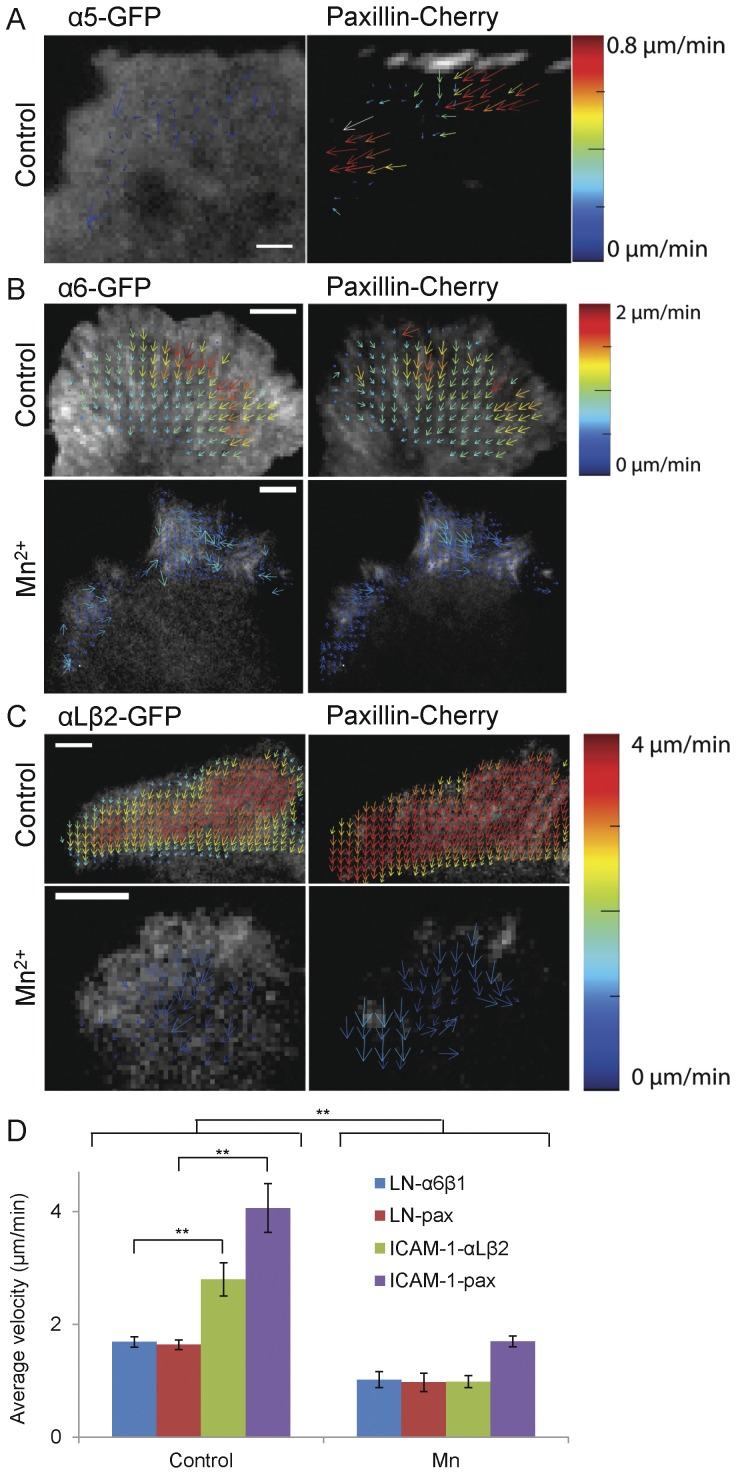
STICS measurements of the retrograde fluxing of paxillin and integrin in CHO.B2 cells plated on FN, LN and ICAM-1 with or without Mn2+.Cells were doubly transfected with the appropriate integrin (left) and paxillin-mCherry (right). (A) α5-expressing cells seldom show slow retrograde flux of paxillin or integrin in adhesions in protruding regions. (B) α6β1 fluxes retrograde in protrusions and is inhibited from 1.68±0.09 to 1.0±0.1 µm/min (P = 0.0051) by addition of Mn2+. Paxillin fluxes are inhibited from 1.64±0.09 to 1.0±0.2 µm/min (P = 0.0051) (C) αLβ2 fluxes retrograde fluxing in protrusions is inhibited by almost a factor of 3 (from 2.8±0.3 to 1.0±0.1 µm/min, P = 0.0016) and that for paxillin are inhibited from 4.1±0.4 to 1.7±0.1 µm/min (P = 0.0016). Scale Bar  = 5 µm. Protein velocity is represented using the rainbow color scale bar. (D). Average fluxing velocity for each condition is presented as the mean ± SEM. αL fluxes faster than α6, along with paxillin (P = 0.0025). The results are from analyses of 29 cells.